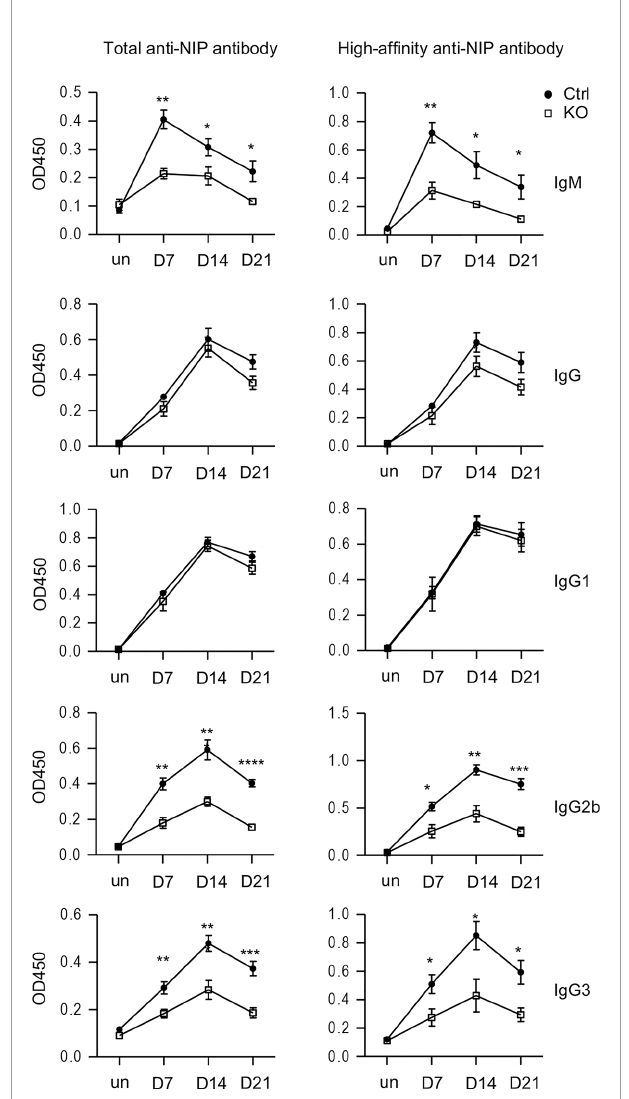
FIGURE 6 | Impaired antigen-induced antibody responses in TSC1-de fi cient mice after immunization. Tsc1 f/f -Cd4Cre and control mice were immunized with NP 17 -CGG in alum. Total and high af fi nity-anti-NIP antibodies before immunization and 7, 14, 21 days after immunization were measured via ELISA. Line plots show Mean ± SEM of serum concentrations of anti-NIP antibodies. Data shown are representative of two experiments. * p < 0.05; ** p < 0.01; *** p < 0.001, **** p < 0.0001 determined by an unpaired two-tailed Student t